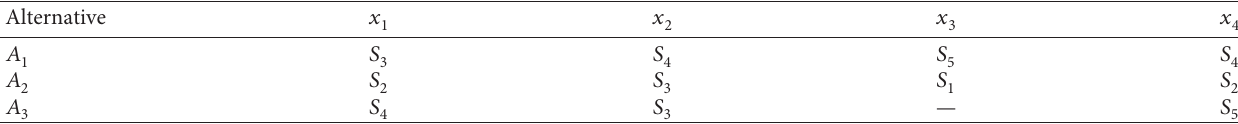
Table 21: The linguistic decision matrix provided by the first DM.